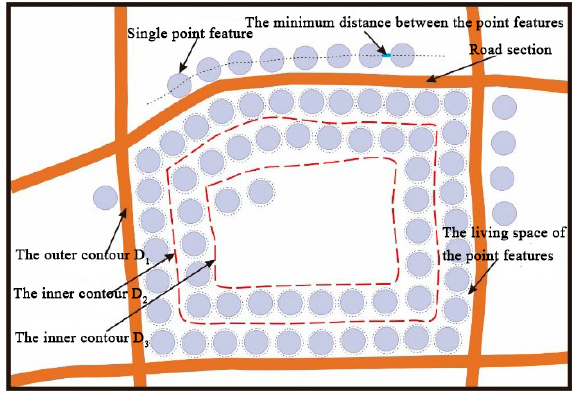
Figure 3. Geometric constraints of road meshes on the point features.